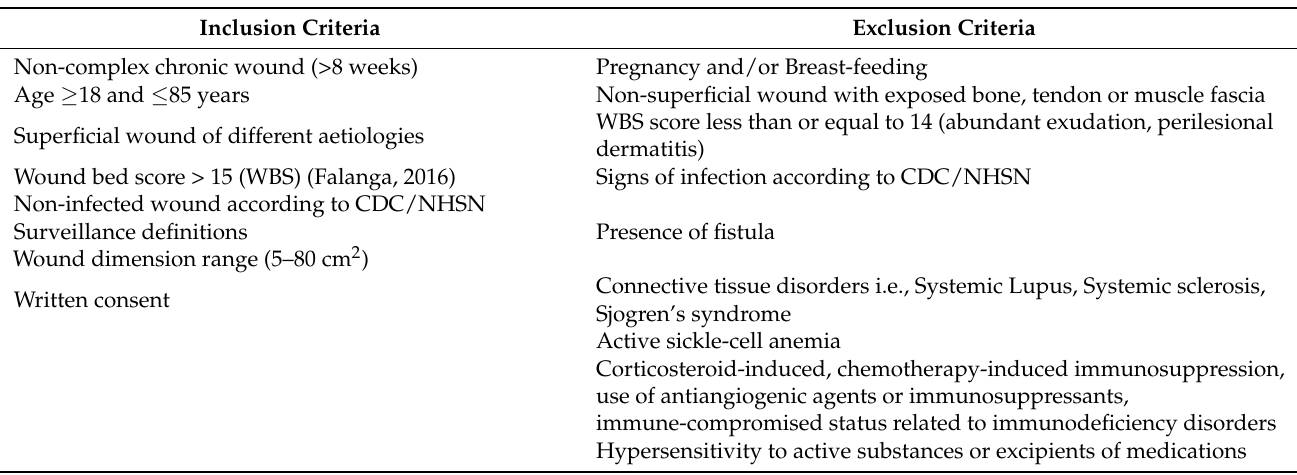
Table 1. Inclusion and exclusion criteria.